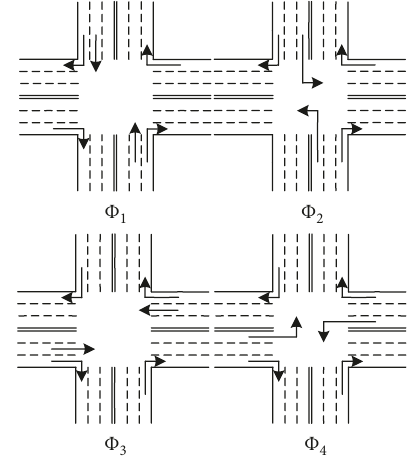
Figure 1: The light phases of one intersection.